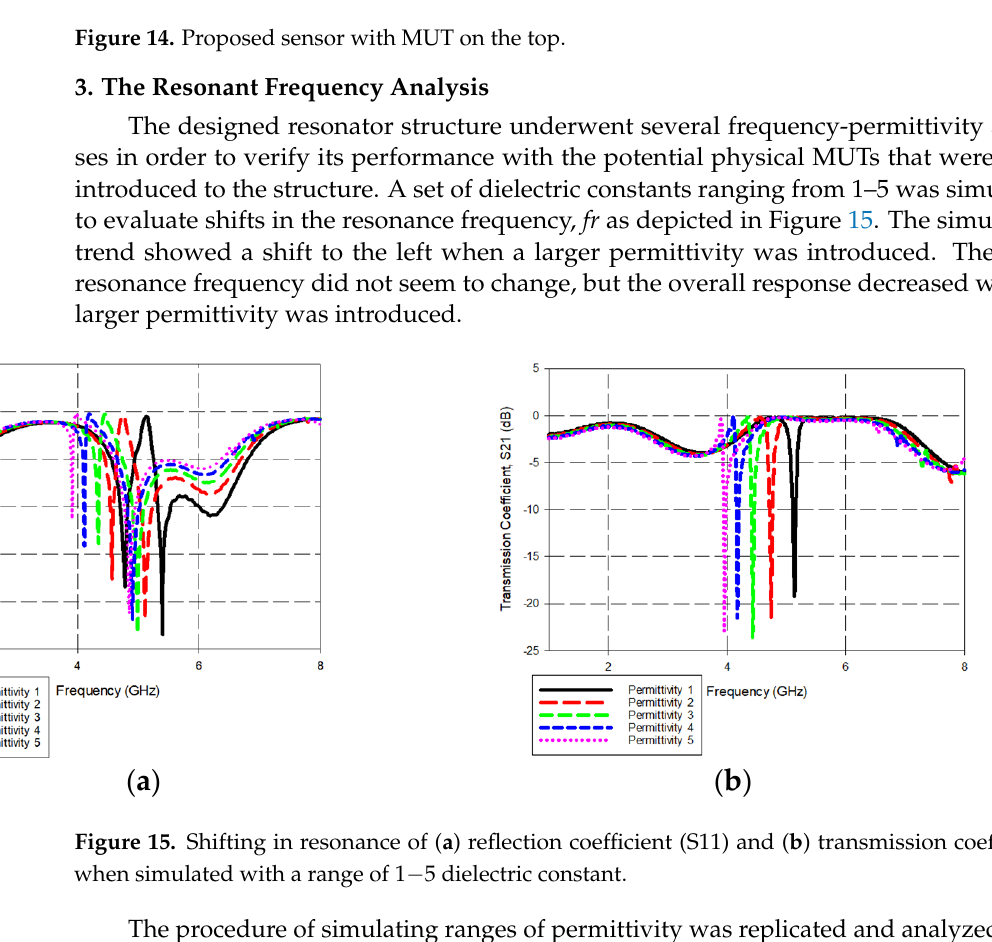
Figure 14. Proposed sensor with MUT on the top.